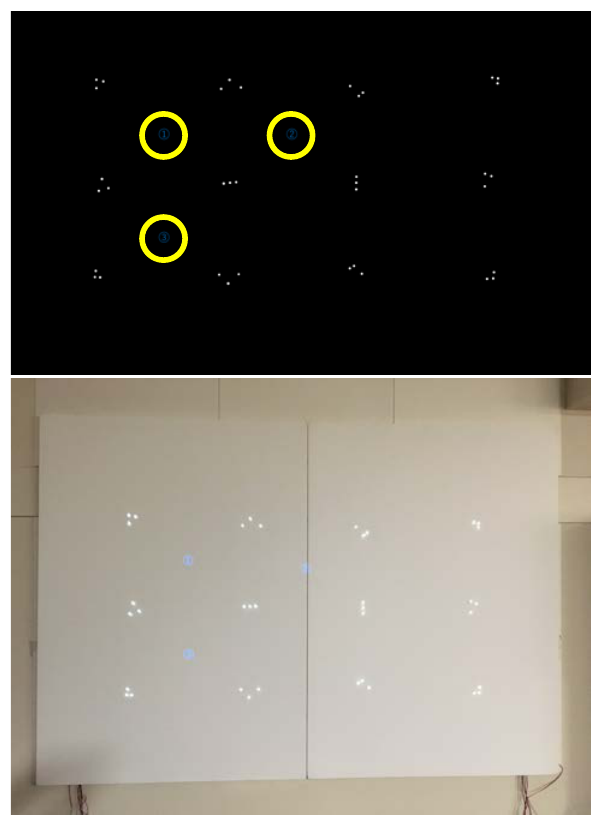
Figure 10: Image source projected on the screen for preliminary experiment (top; yellow circles added for enhancement) and screen with image source projected (bottom).